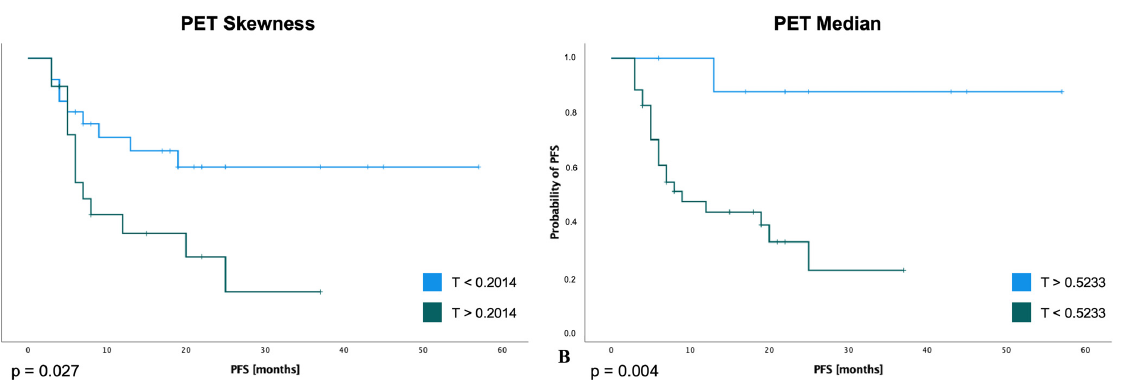
Figure 3. Radiomic features boxplot. The radiomic PET feature PET-Skewness di ff erentiated well between non-responders (red) and responders (green) to immunotherapy after the second follow- up. The Radiomic PET feature PET-Median di ff erentiated well between progression (green) and no- progression (red)